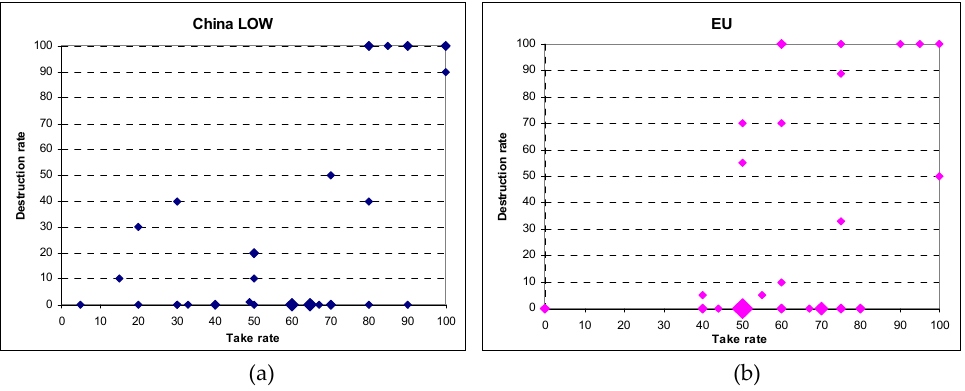
Figure 3. Take rates and destruction rates in CHINA LOW ( a ) and EU ( b ). Note: The size of symbols is proportional to the underlying number of observations. EU data are from Bosman et al. [17]. A binary logit regression with destruction as the dependent and the take rate as the independent variable shows that the impact of the take rate is significant (see also Table 6). Coefficients for t are not significantly different between EU and CHINA LOW ( p = 0.30, Chi2 test), while only a weakly significant difference in intercepts is observed ( p = 0.09).